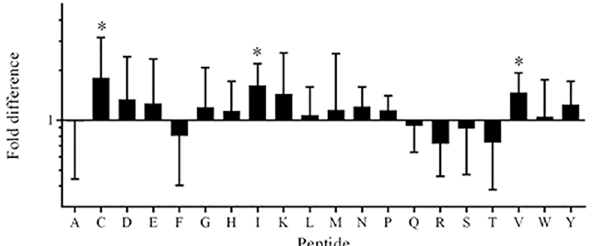
Fig 4. Effects of acyclovir (2 mg/mL) on the affinity of C-terminal residues for HLA-B * 57:01. Values are represented as geometric mean with 95% CI of the fold difference between vehicle/acyclovir treatment. The experiment was run 6 times with each run performed in triplicates. Analyzed for statistical significance by column statistics; p < 0.05 was considered significant ( * p < 0.05; ** p < 0.01; *** p < 0.001). The most pronounced affinity increases for HLA-B * 57:01 in the presence of 2 mg/mL of acyclovir were found for peptides with a cysteine, isoleucine and valine at the